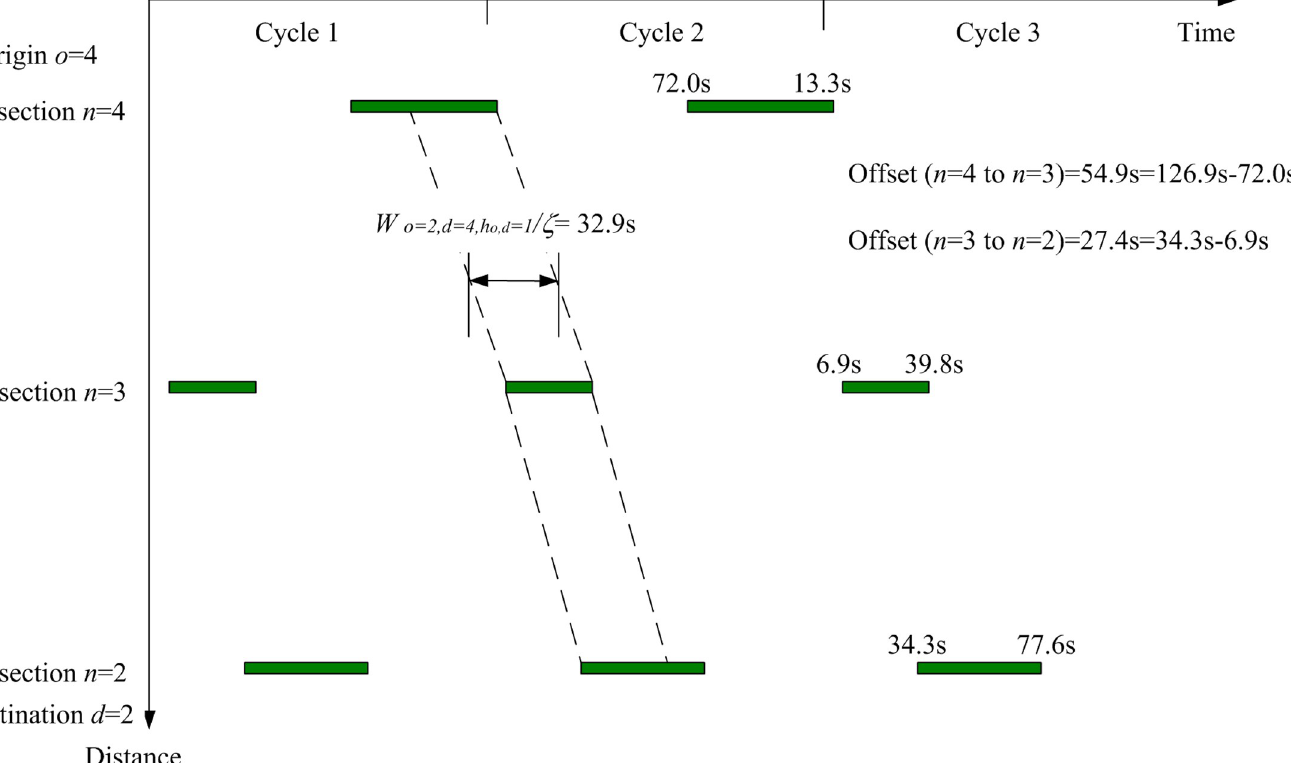
PLOS ONE | https://doi.org/10.1371/journal.pone.0216958 June 10,